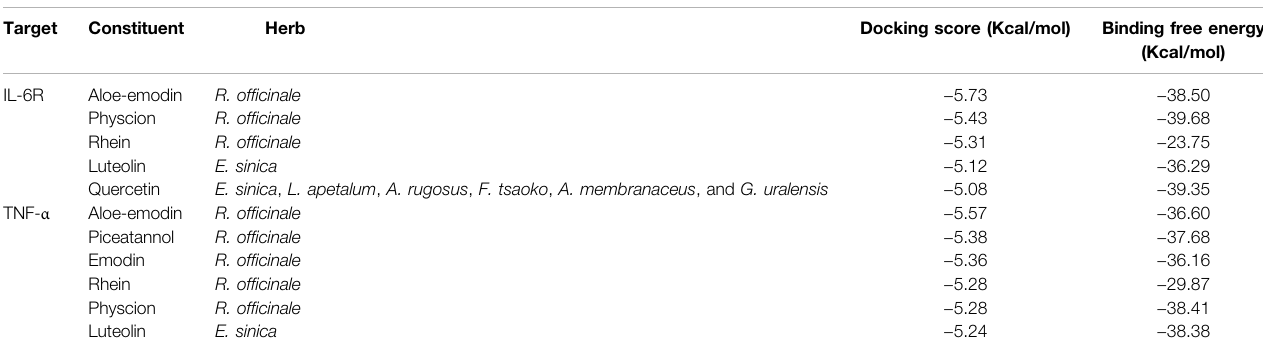
TABLE 3 | Information of the representative compounds. Target Binding free energy